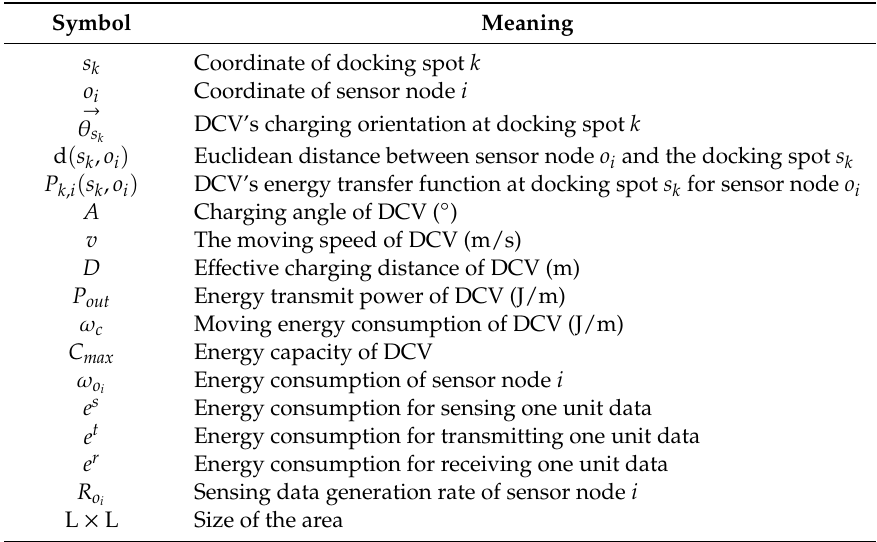
Table 1. Symbol and Notations.